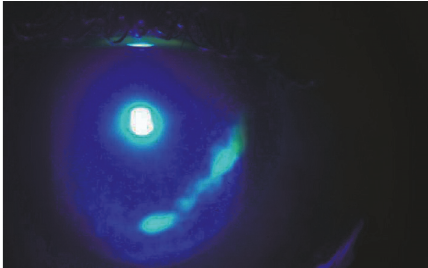
Figure 2: Fluorescein staining and cobalt blue filter, epithelial defect at presentation.